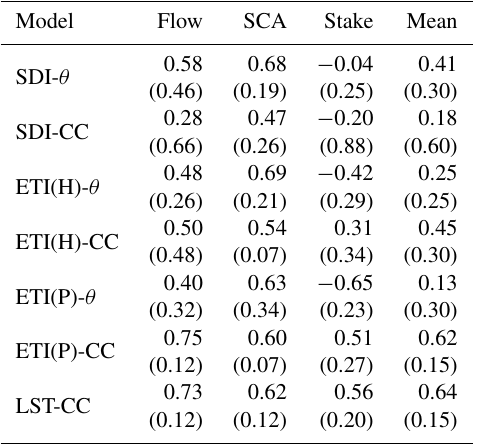
Table 7. Regionally averaged evaluation scores during model val- idation by model. Values in parentheses are absolute difference in model validation scores between regions. Evaluation methodology and metrics are described in Sects. 2.5 and 3.3.